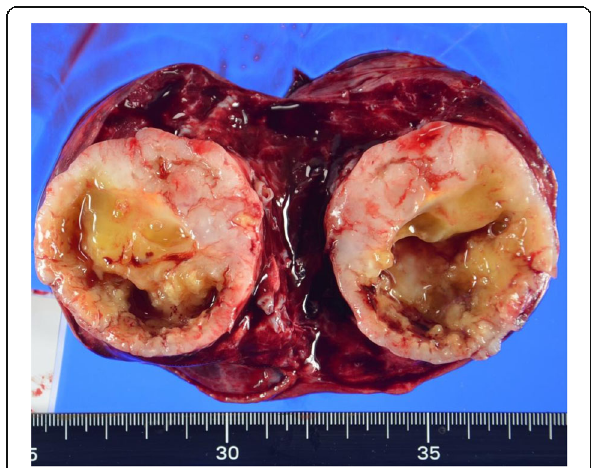
Fig. 3 The divided surface of resected specimen of the lung. The pulmonary chondroma was a white lesion and was easily separated from surrounding lung tissue